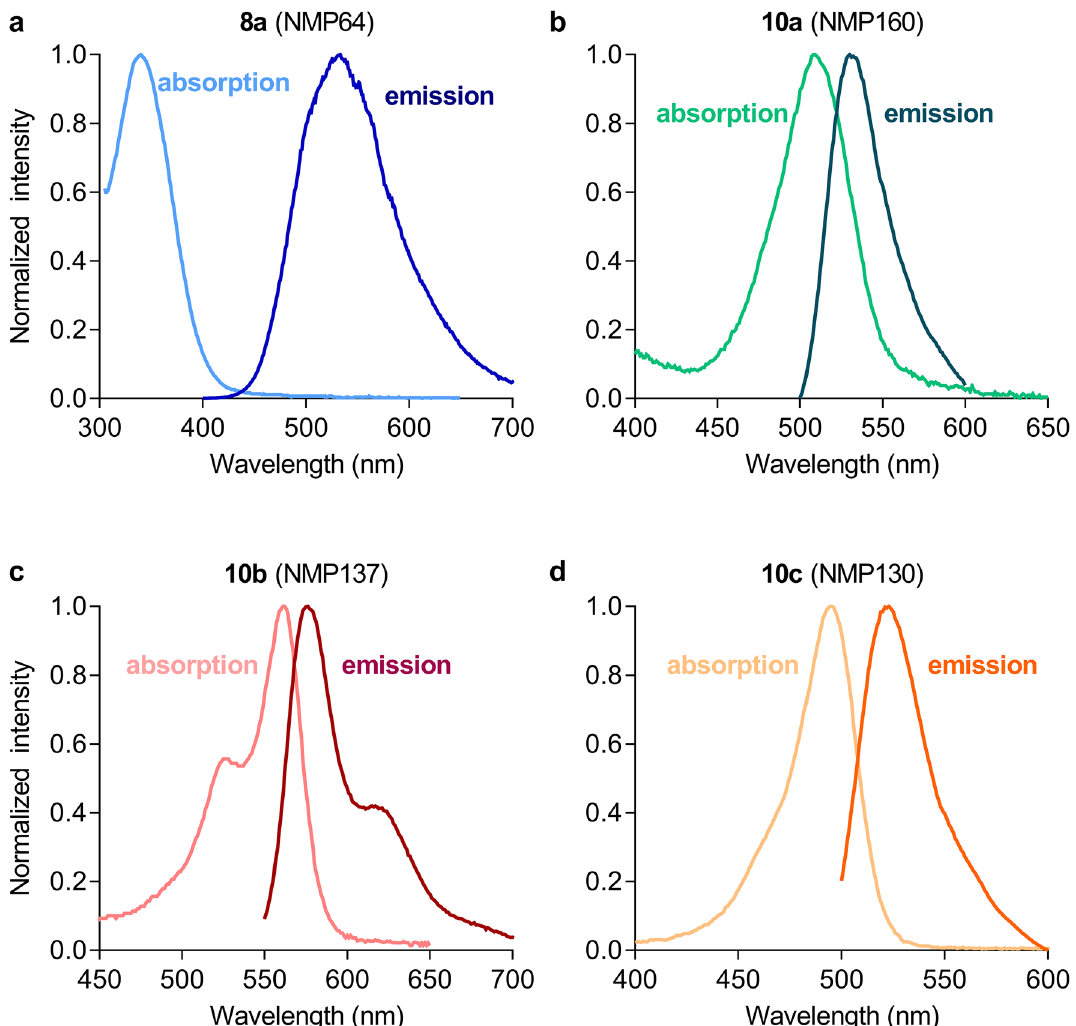
Figure 4. Spectral properties of fluorescent ligands 8a and 10a-c. Absorption and fluorescence emission spectra of the fluorescent ligands 8a and 10a - c were obtained on a microplate reader and normalized to the respective maximum signal of each